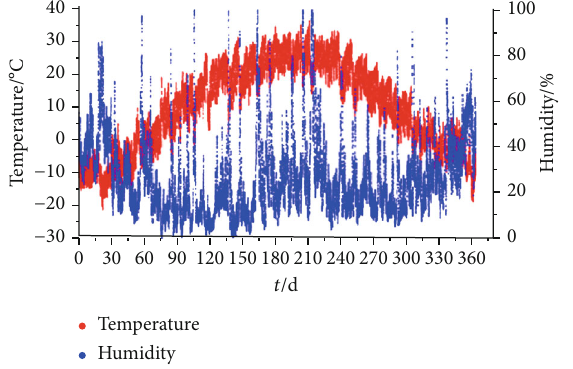
Figure 2: Mogao Grottoes year-round atmospheric environment.